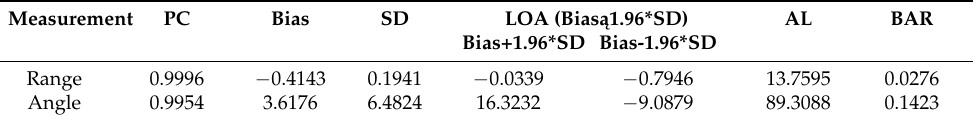
Table 3. Results of measurement error analysis using the Pearson correlation coefficient, and the bias, SD, and BAR metrics obtained from Bland–Altman analysis a .